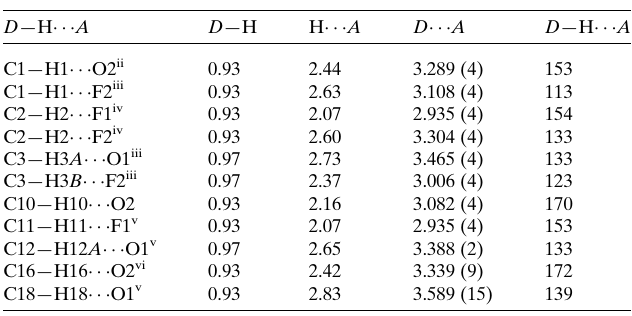
Table 2 Hydrogen-bond geometry (A˚ , (cid:5)